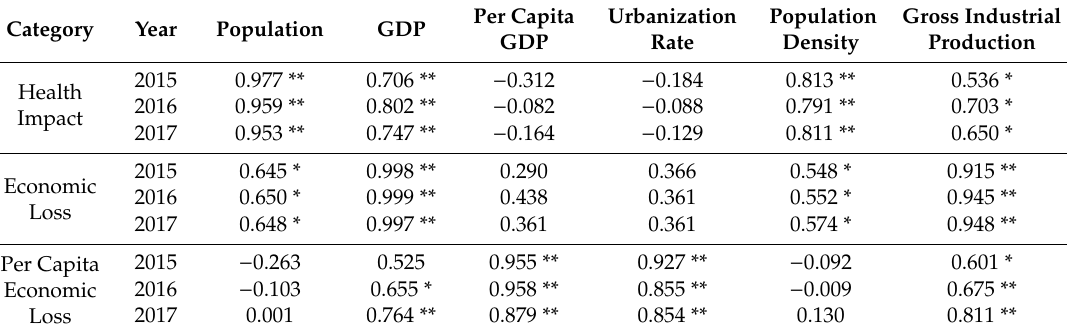
Table 4. Correlation between PM 2.5 related health impact, economic loss and socioeconomic